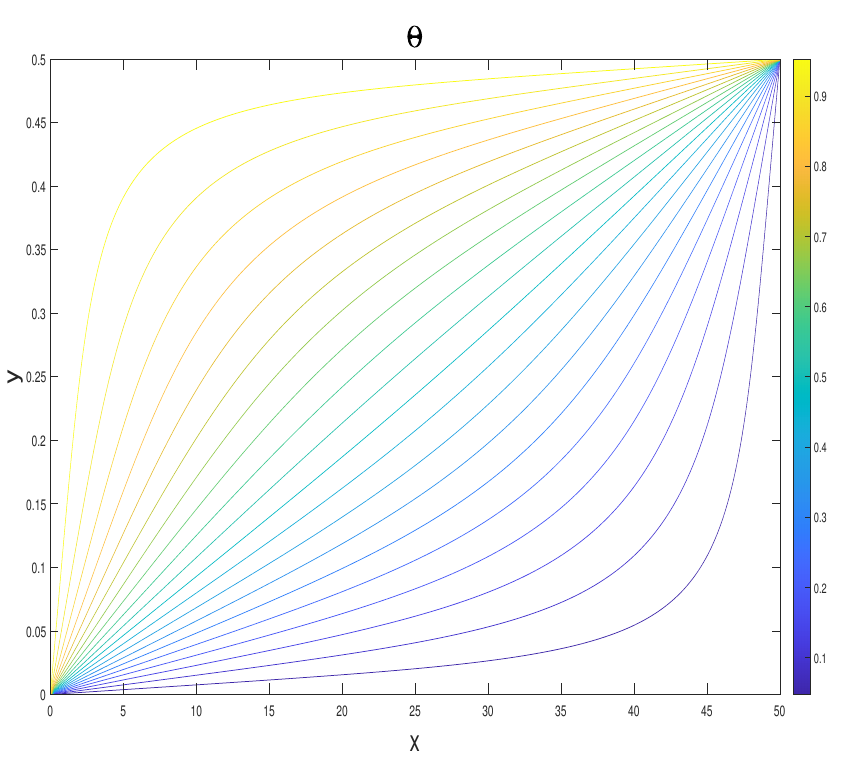
Figure 8. Contour plot of the temperature profile at t = 10.